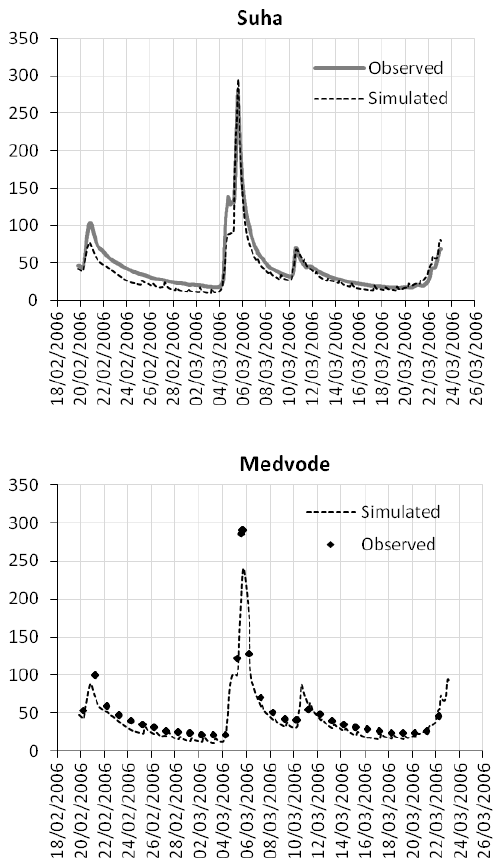
Fig. 4b. Model results for the calibration period, 19/02/2006 to 23/03/2006. Medvode observed hydrograph is plotted with dots due Figure 4b: Model results for the calibration period, 19/02/2006 to 23/03/2006. Medvode 4 to the daily time observed hydrograph is plotted with dots due to the daily time resolution. 5